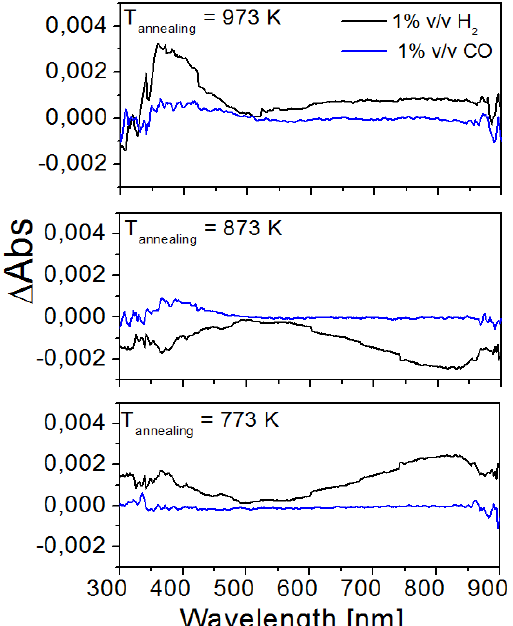
− Abs , curves of samples annealed gas Air and CO at operating temperature 573 2